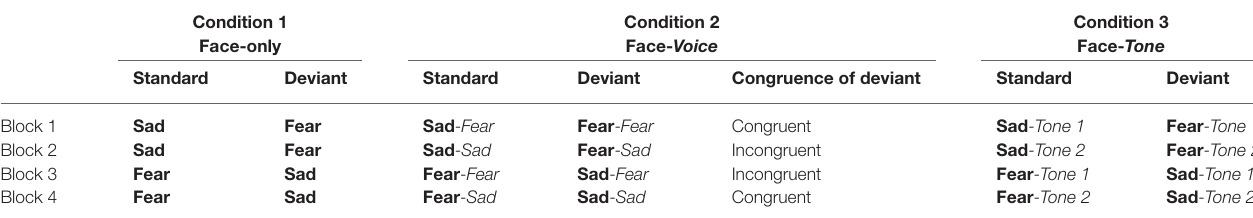
TABLE 2 | Types of standard and deviant trials of each block in each condition . Condition 1 Condition 2 Condition 3 Face-only Face- Voice Face- Tone Standard Deviant Standard Deviant Congruence of deviant